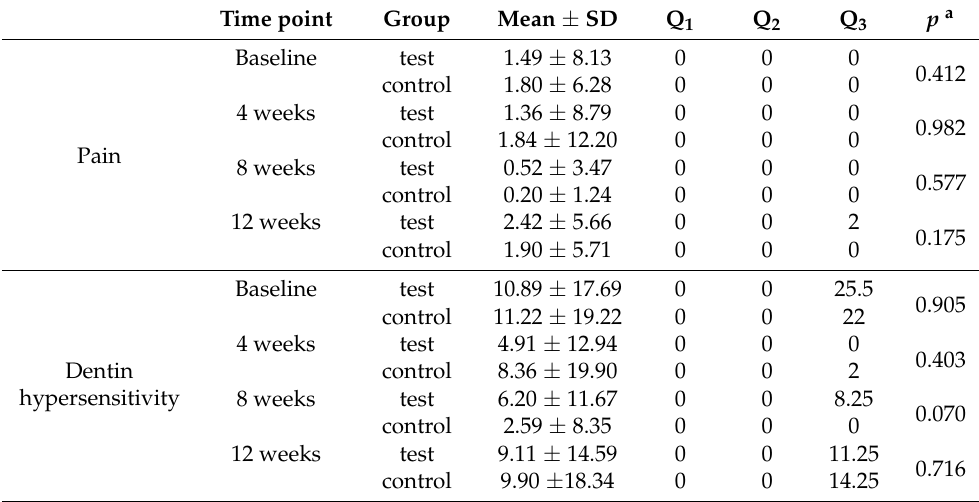
Table 5. Pain and dentin hypersensitivity symptoms of participants in two groups (safety set).